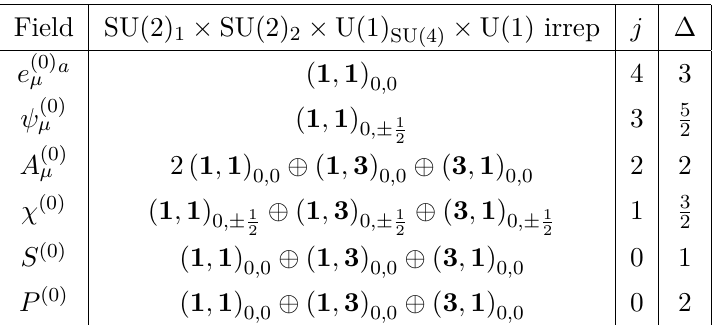
Table 7 . The KK spectrum for the level n = 0 of 11d supergravity on AdS 4 × S 7 / Z 4 p with the orbifold action in (2.9) and the antiperiodic spin